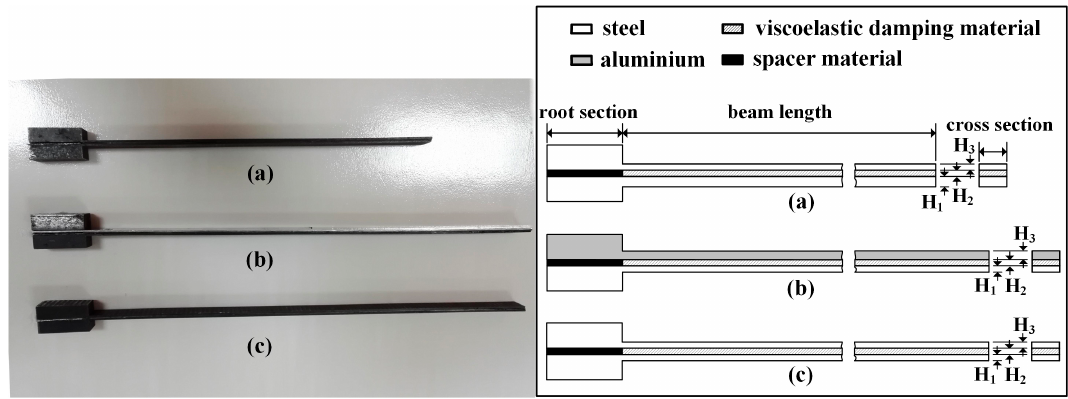
Figure 7. Sandwich beam specimens: ( a ) short asymmetrical specimen H 1 ≠ H 3 , ( b ) long asymmetrical specimen H 1 ≠ H 3 and ( c ) long symmetrical specimen H 1 = H 3 .